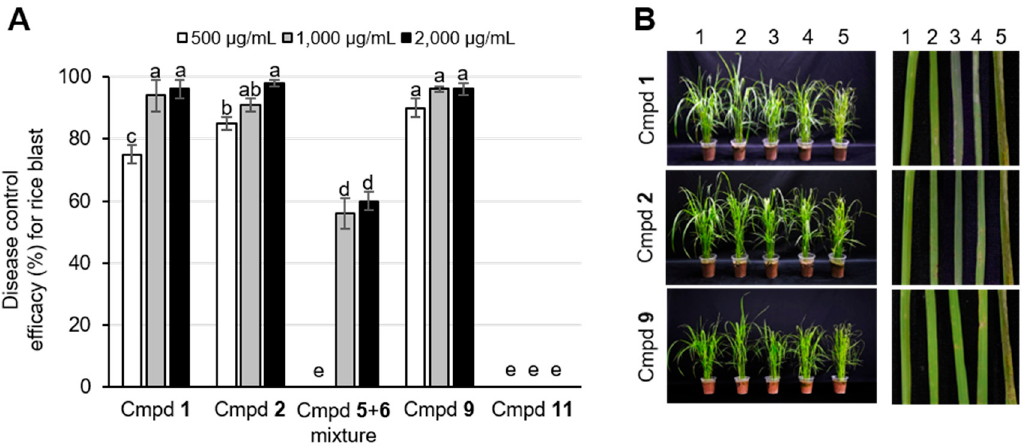
Figure 3. Disease control efficacy of the compounds isolated from Platycladus orientalis against rice blast. ( A ) Disease control efficacy for rice blast treated by each compound with different concentrations. The bars represent the mean ± standard deviation of two runs with three replicates. The bars with different letters are significantly different from each other at p < 0.01 according to Duncan’s new multiple range test. Cmpd 1 , pinusolide; cmpd 2 , 15-methoxypinusolidic acid; cmpd 5 , sandracopimaric acid; cmpd 6 , isopimaric acid; cmpd 9 , 8 β ,1 8 -dihydroxysandaracopimar-15-ene; cmpd 11 , α -cedrol. ( B ) Representative plants and leaves with rice blast disease. Line 1, blasticidin-S (50 μ g/mL) treatment as a positive control; line 2, 2000 μ g/mL treatment of each compound; line 3, 1000 μ g/mL treatment of each compound; line 4, 500 μ g/mL treatment of each compound; line 5, 0.025% Tween 20 solution treatment as a negative control.